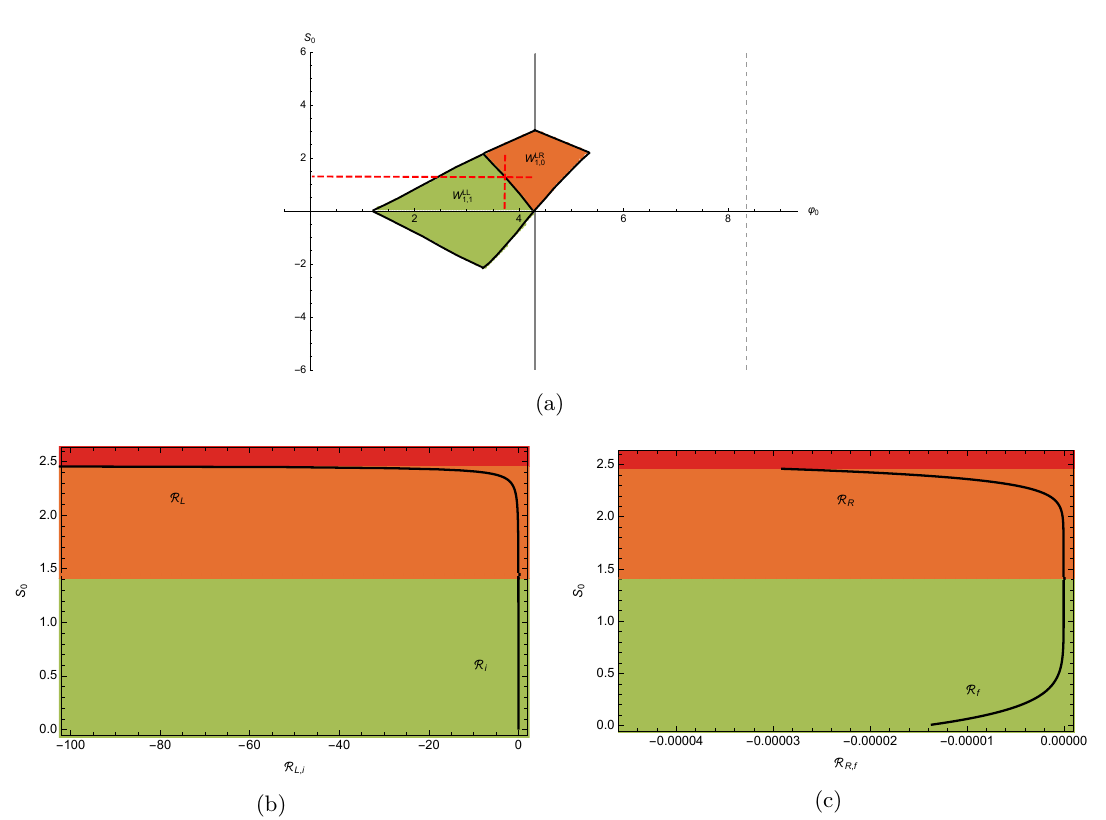
and W LL region and their joint boundary. 1 , 0 1 , 1 or UV fixed points of the flow tend to zero f R